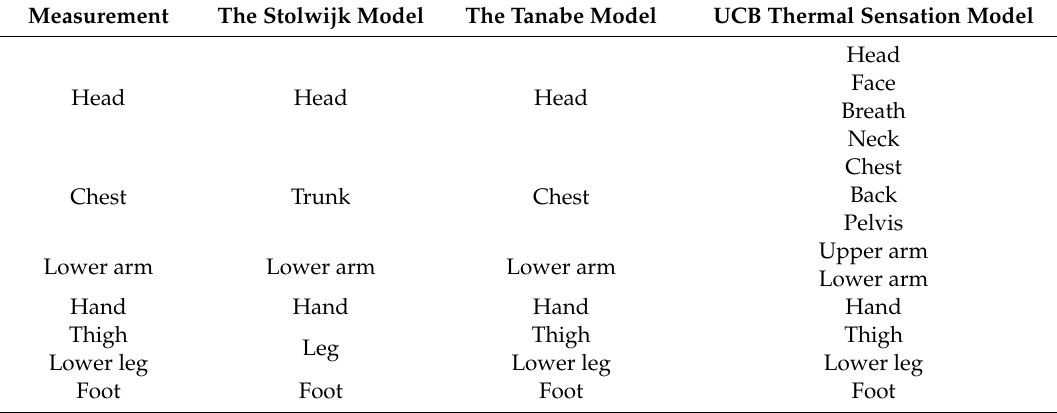
Table 5. Body segment correspondence among the measurement, the Stolwijk model, the Tanabe model, and the UCB sensation thermal model.